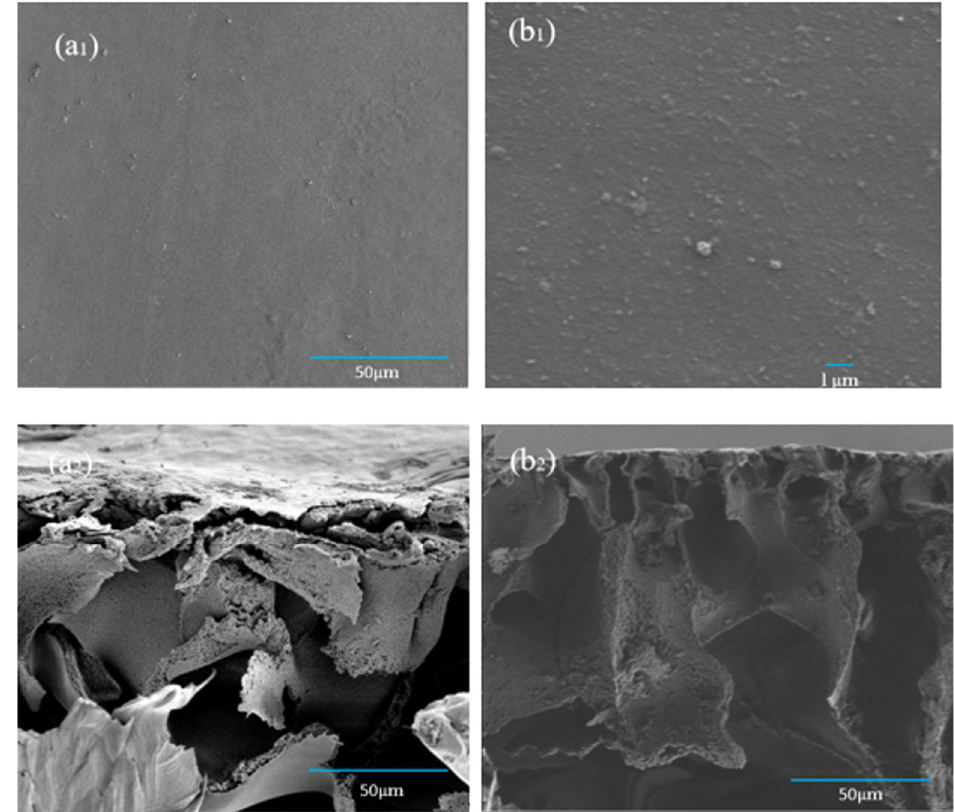
Figure 9. SEM images of the morphology CA membrane of surface ( a 1 )and section ( a 2 ) and CA/ZIF-8 membrane of surface ( b 1 )and section ( b 2 ).